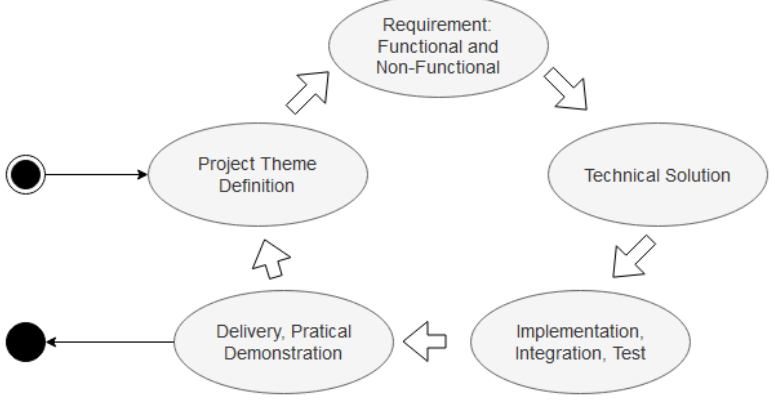
Figure 1. Project cycle: phases include quality